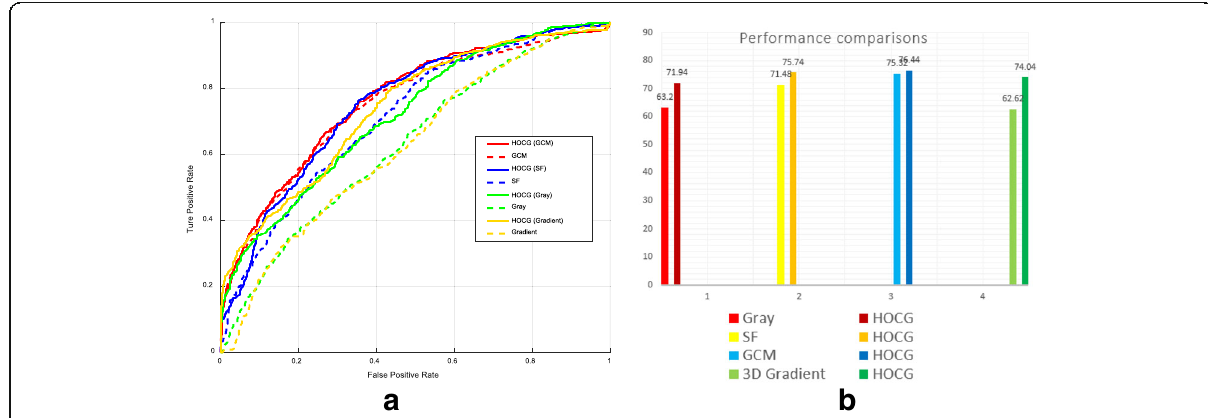
Fig. 6 Performance comparisons between the HOCG descriptor and its based features via ( a ) ROC curves and ( b ) bar diagrams